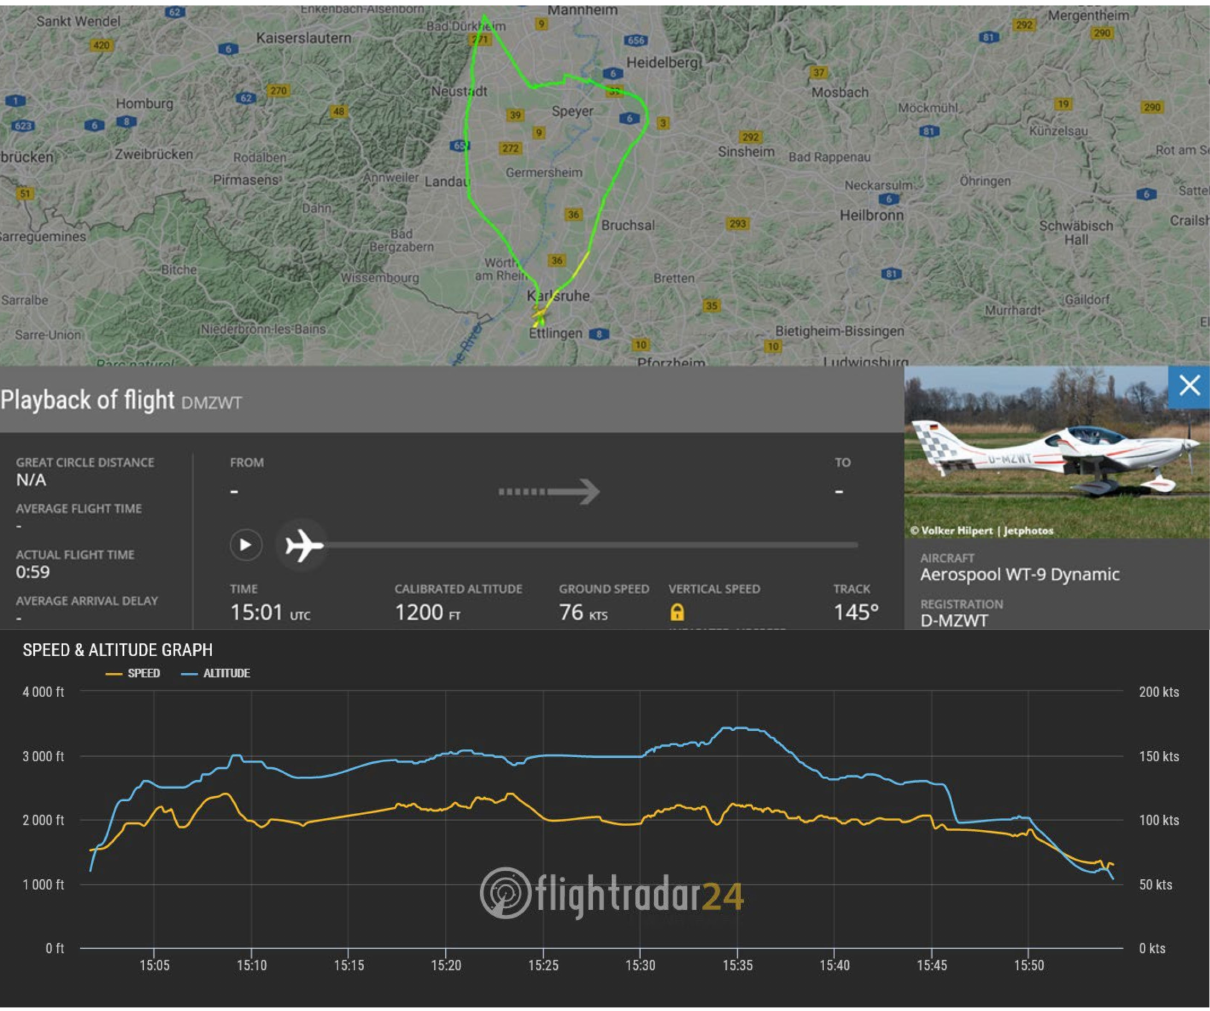
Figure 3. Real flight data from Flightradar24